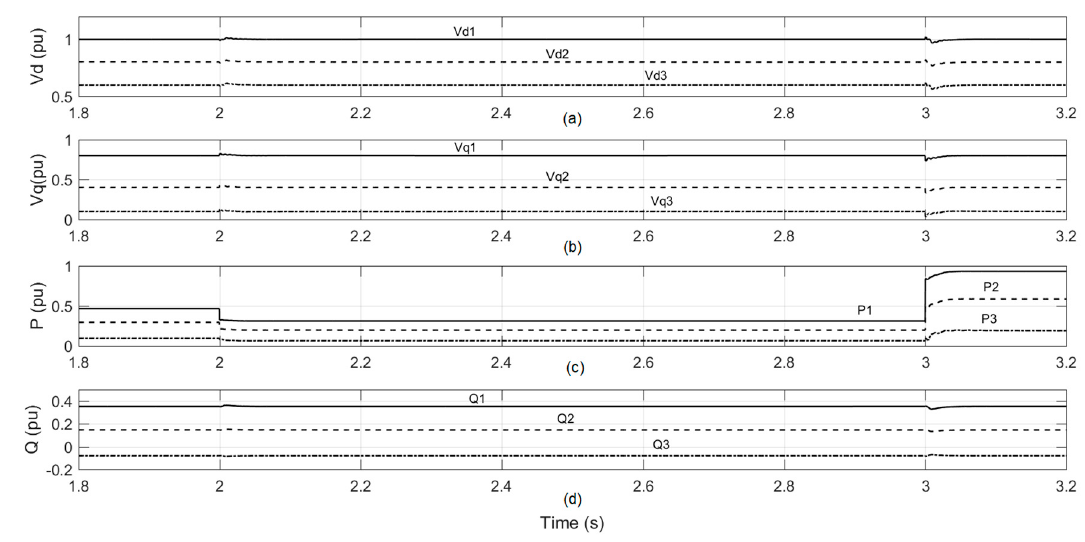
Figure 6. Dynamic performances of DG 1, DG2, and DG 3 as a result of step changes in the load resistance in three-phase system. ( a ) d-component of the load voltages at three DGs. ( b ) q-component of the load voltages at three-DGs. ( c ) Output active power of three DGs. ( d ) Output reactive power of three DGs.